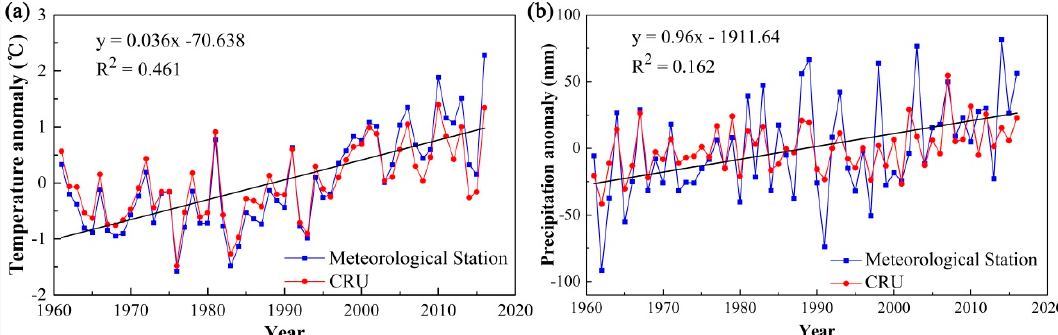
Figure 12. Anomalies analysis of mean summer temperature ( a ) and annual total precipitation ( b ) in the Qilian Mountains.